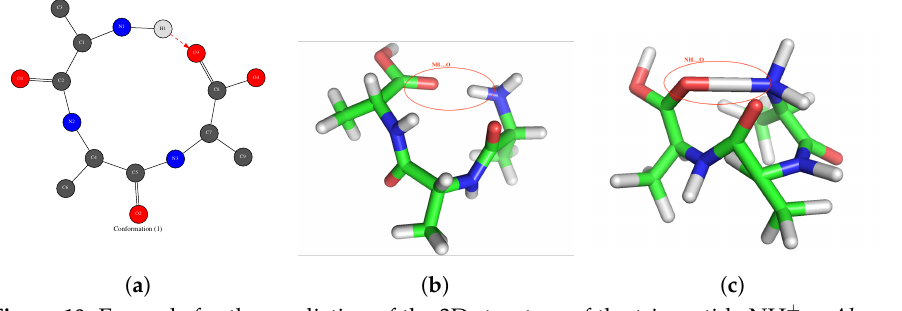
Figure 10. Example for the prediction of the 3D structure of the tri-peptide NH + from the knowledge of a 2D-MolGraph. ( a ) The 2D-MolGraph of the NH + (C 9 H 18 N 3 O 4 ) tri-peptide extracted from a snapshot of a DFT-MD trajectory. ( b ) Associated 3D structure known from the DFT-MD trajectory. ( c ) The 3D structure of the best predicted solution by the presently developed game theory coupled to the learning method.